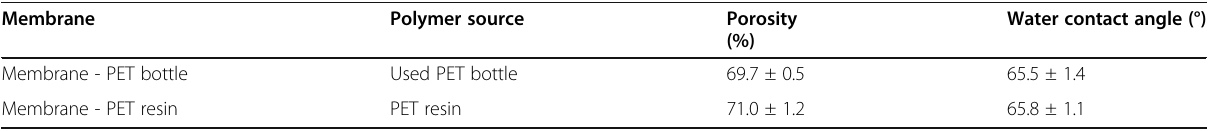
Table 3 Comparison of porosity and water contact angle of the membrane from PET bottle and those from PET resin without